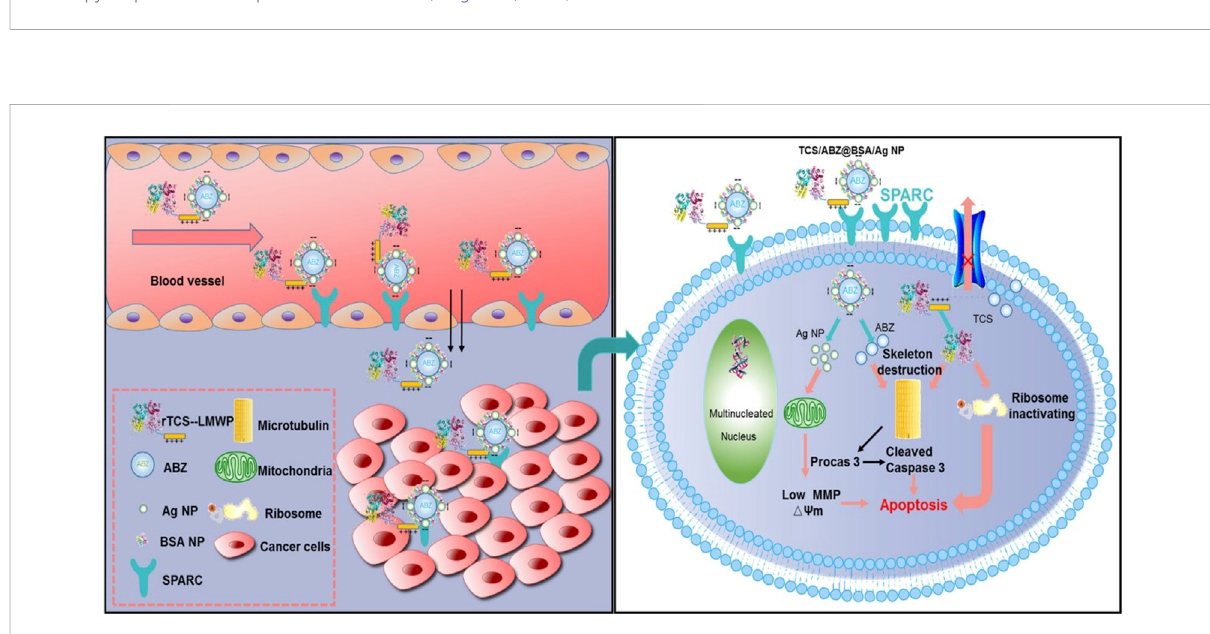
FIGURE 10 Schematic illustration of tumor delivery and synergistic effect via co-delivery of TCS and ABZ by silver nanoparticles. Reproduced with permission from Ref. (Tang et al., 2017).